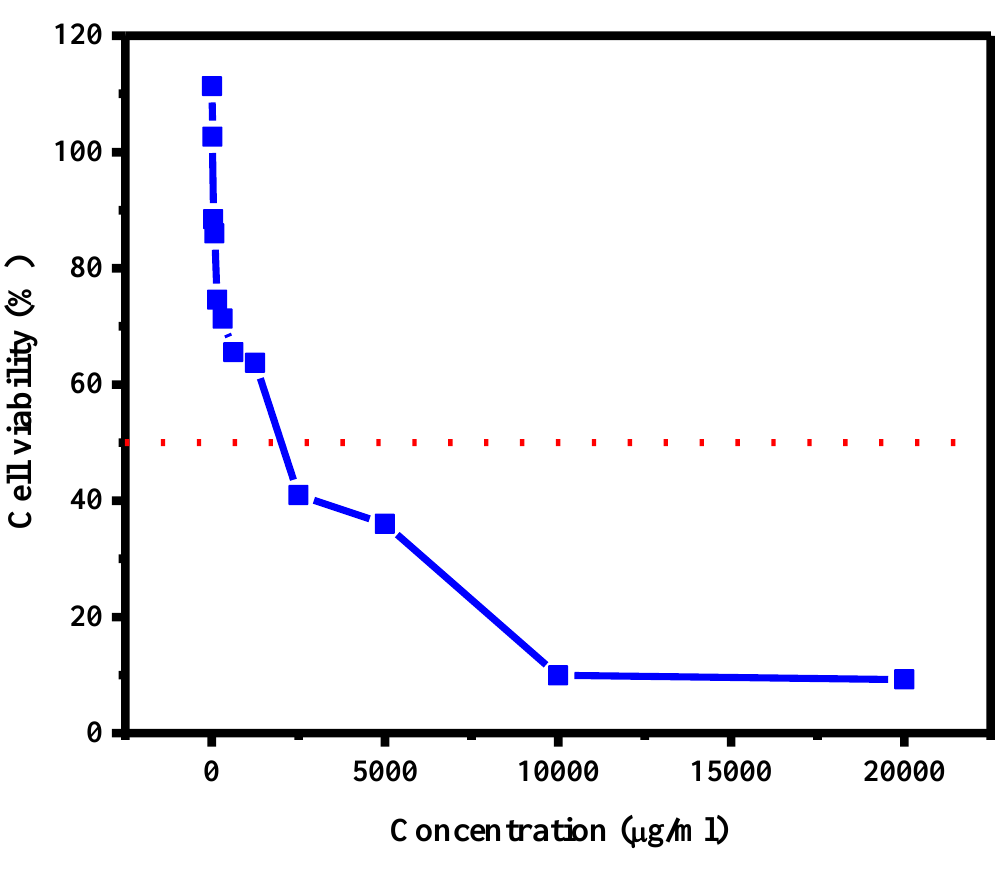
Figure 7. Determination of IC 50 of viable cells of CS cast film with metal oxides.